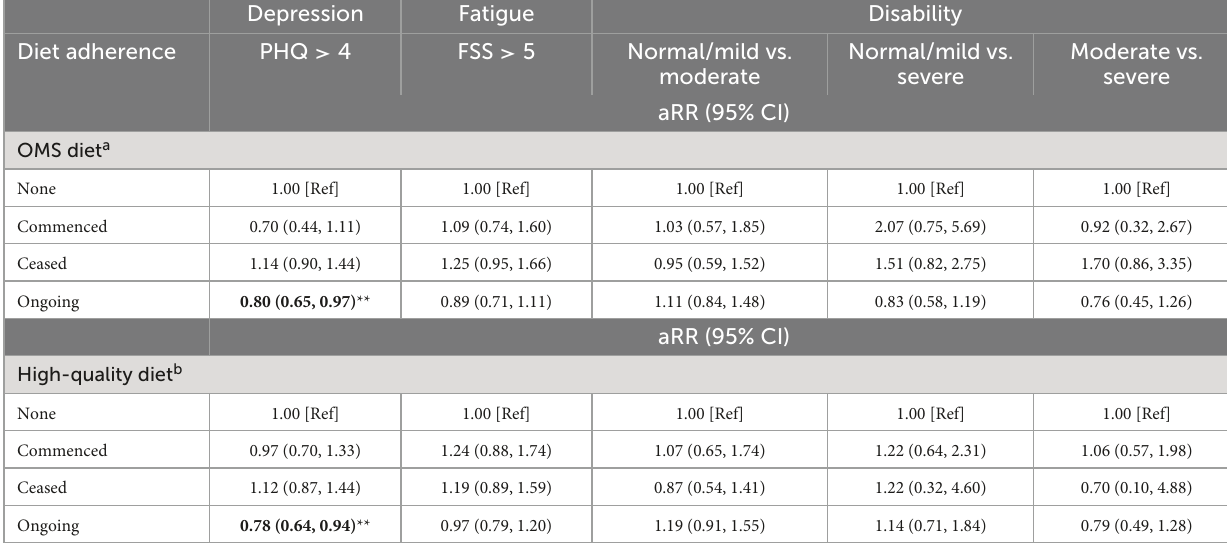
TABLE 3 Associations between OMS-diet and high-quality diet adherence with 7.5 years health outcomes ( N = 671). Depression Fatigue